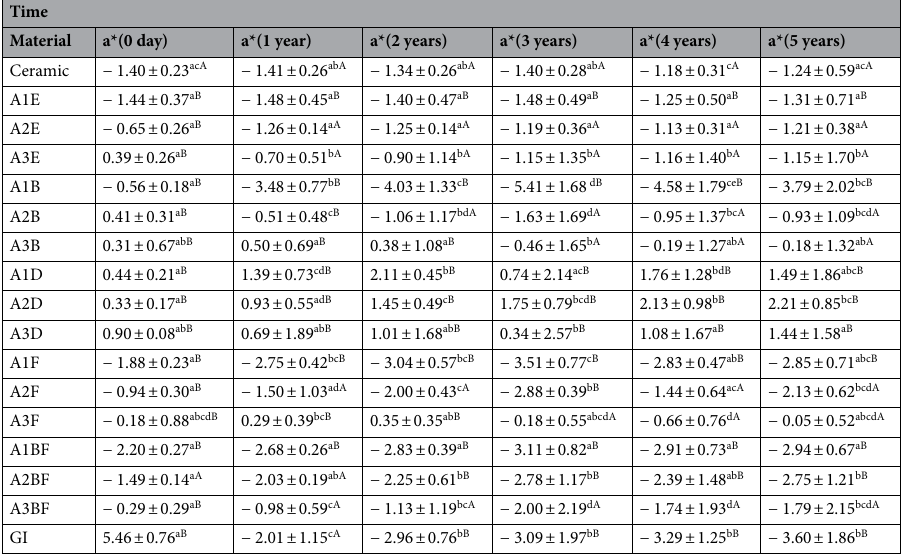
Table 4. Changes in redness of the restorative materials and the ceramic across 5 years. Lower case letters indicate significant difference within the row ( p < 0.05). Upper case letters indicate significant difference within the column ( p < 0.05).